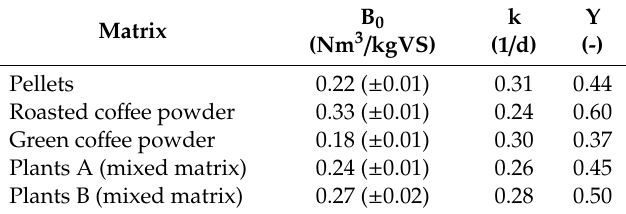
Table 5. Results of batch anaerobic digestion tests performed on a single matrix and mixed matrices. Matrix